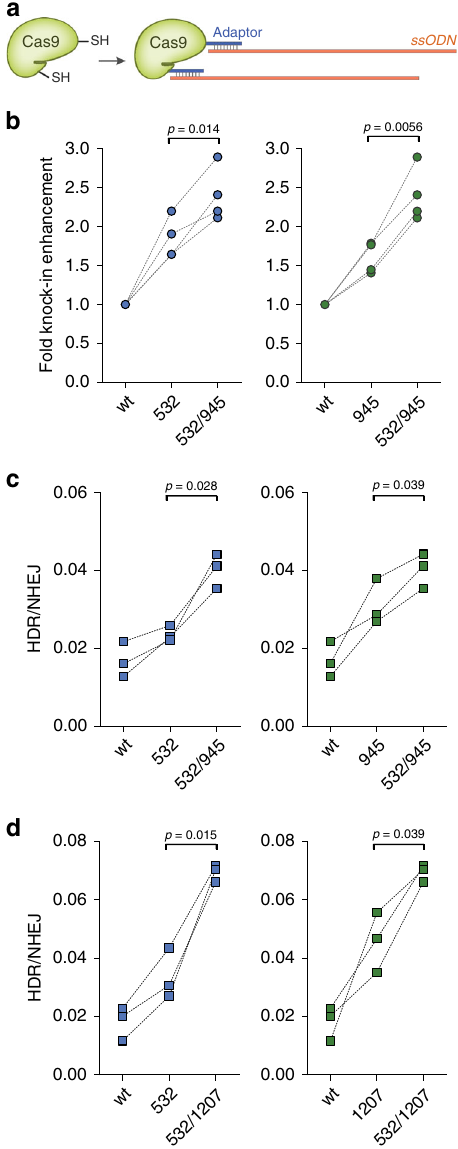
Fig. 4 Multivalent display of ssODN further enhances HDR ef fi ciency. a Schematic illustrating the production of Cas9 double-ssODN conjugates. b HiBiT sequence knockin at the GAPDH locus was detected in U2OS cells ( n = 4 biologically independent experiments). c , d Two-base exchange at the RBM20 locus was detected in HEK-293FT cells. Unlabeled wild-type Cas9 (wt) and Cas9-adaptor conjugates labeled at the indicated residues were used ( n = 3 biologically independent experiments). P -values were calculated by paired two-tailed t -test. Source data are provided as a Source Data fi